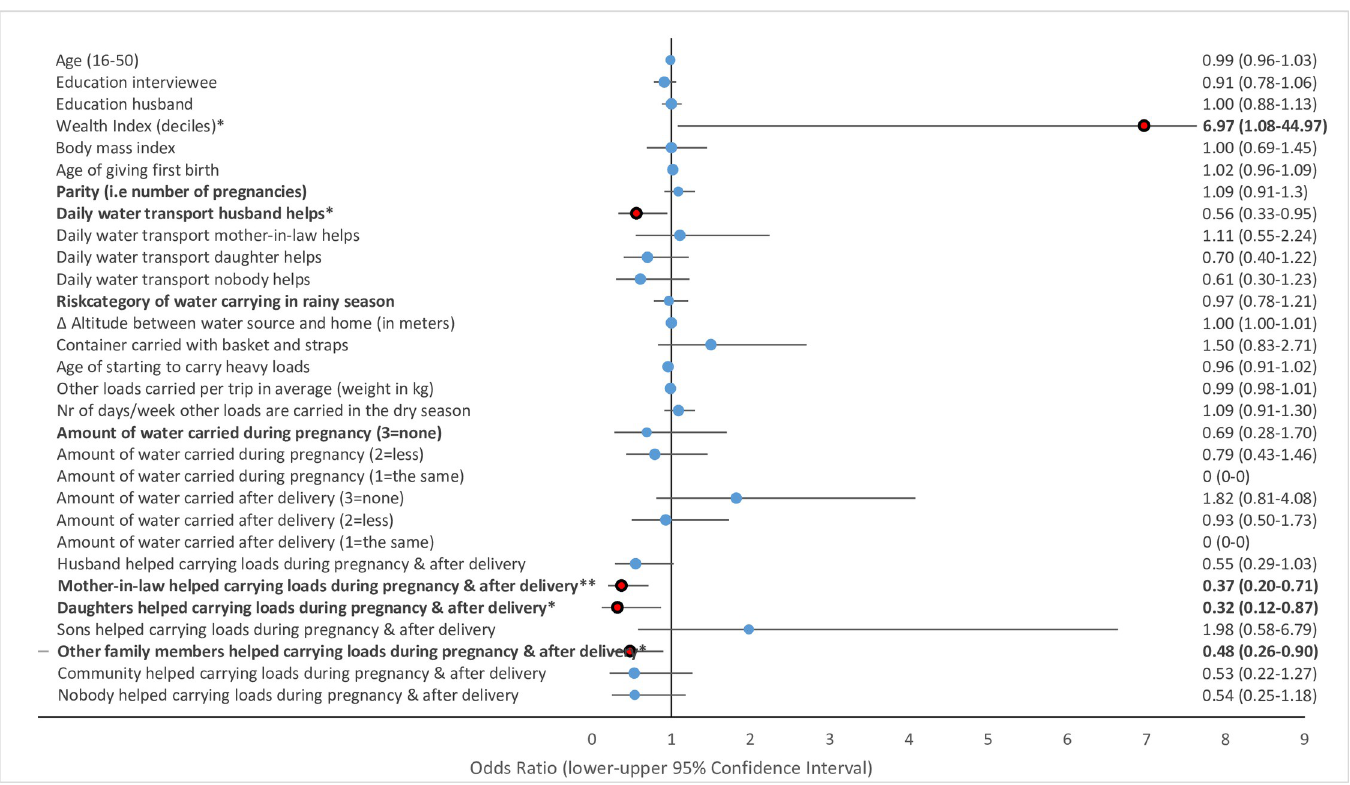
Fig 4. Association of risk factors with pain in the knees in multivariate GLMM. ( ��� = significant at the p < 0.001-level, �� = significant at the p = 0.01-level, � = significant at the p = 0.05-level; = odds ratio statistically non-significiant, ... = odds ratio statistically significant).